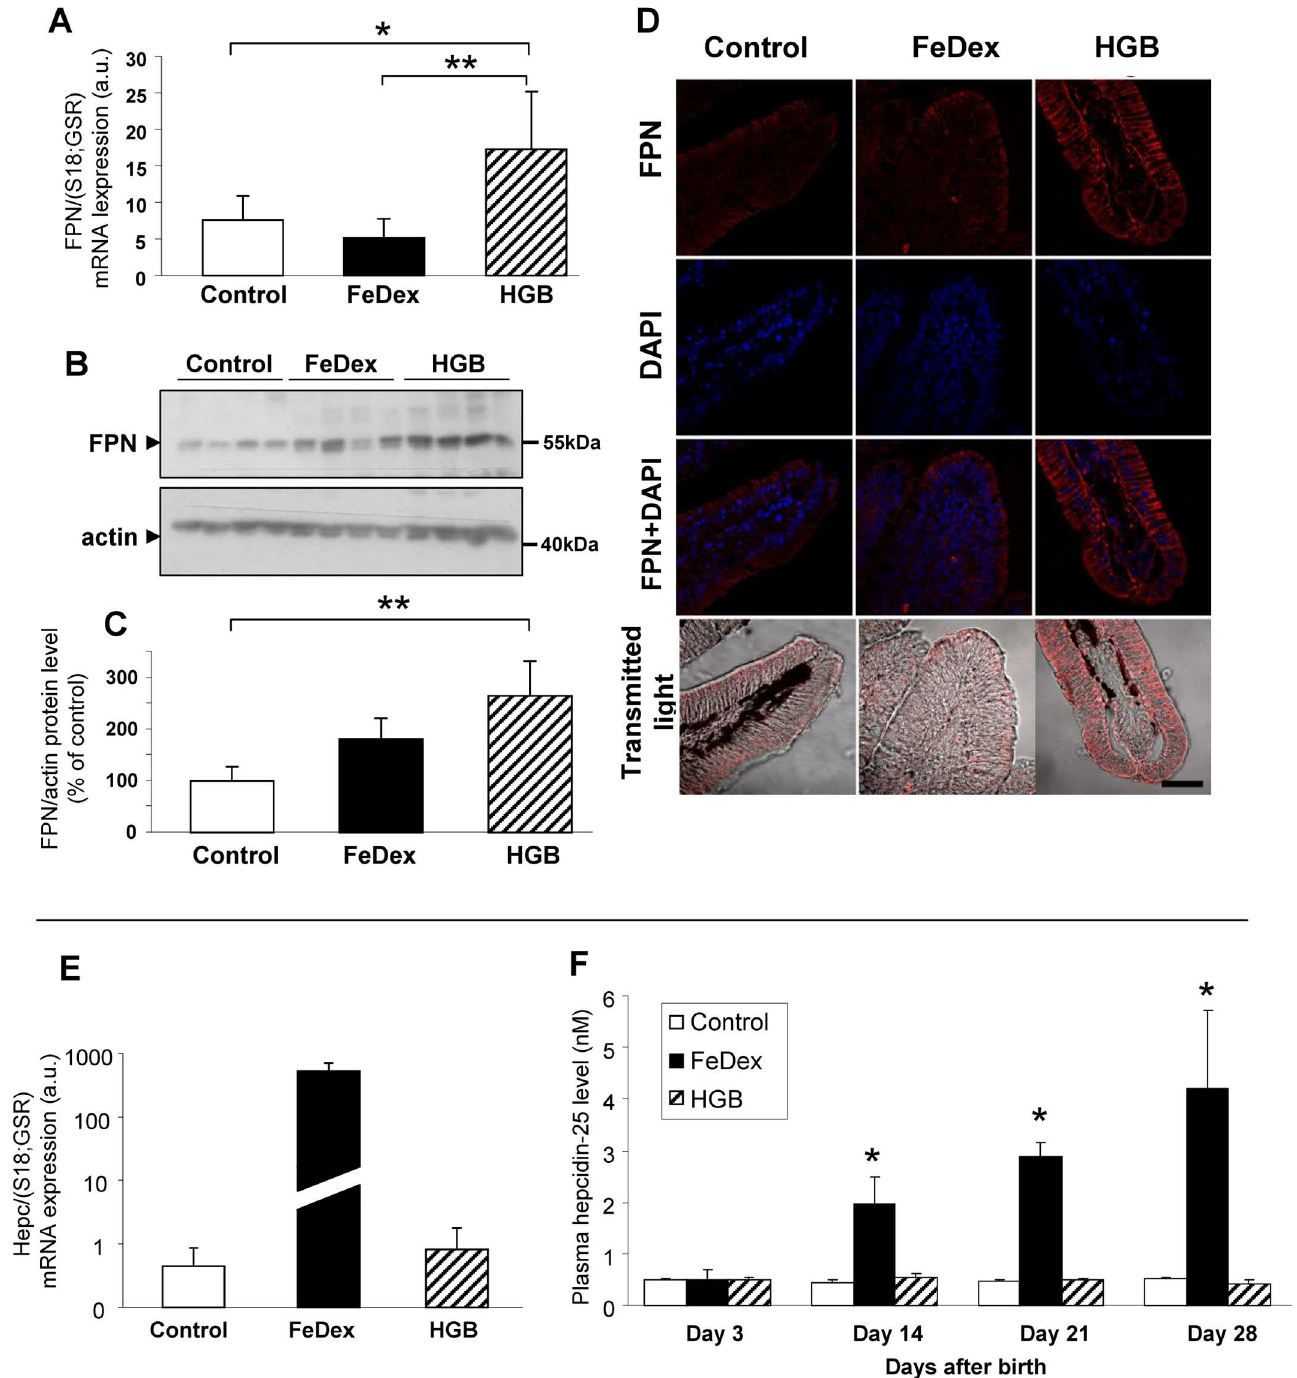
Fig 5. Increased Fpn expression in the duodenum of hemoglobin-supplemented piglets is associated with reductions in both hepatic hepcidin mRNA levels and plasma hepcidin-25 concentration. (A) RT-qPCR analysisof Fpn mRNA expression. The histogram displaysFpn mRNA levels in arbitrary units (means ± S.D., n = 7). (B and C) Western blot analysisof Fpn protein levels in membrane fractions preparedfrom duodenalscrapings.A representative immunoblot is shown (B) . Immunolabelled Fpn bandsfrom separateblots performed on scrapingsisolated from 8 piglets were quantifiedusing a MolecularImager, and Fpn protein levels (means ± S.D.) are plotted in arbitrary units (C) . (D) Immunofluorescent staining of Fpn in the duodenum. To confirm the specificity of Fpn detection, duodenumsections of pigletswere incubatedwith only the secondary antibody. No Fpn stainingwas detected in these negativecontrols. Counterstaining of nucleiwas performed with DAPI. Duodenummorphologyis shown in transmitted light. (E) RT-qPCR analysisof hepcidinmRNA expressionin the liver. The histogram displayshepcidinmRNA levels in arbitrary